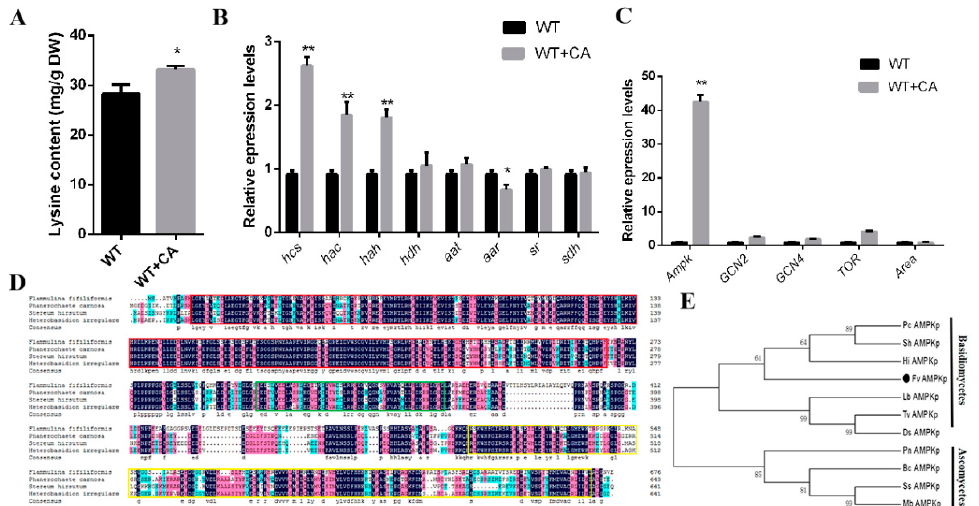
Figure 5. Molecular mechanism of citric acid regulation of lysine biosynthesis in Flammulina filiformis as well as phylogenetic analysis and alignment of the AMPK domains. The asterisks indicate significant differences compared with the untreated strains (Student’s t-test: * p < 0.05 and ** p < 0.01). ( A ) Lysine content of F. filiformis under optimal citric acid induction. ( B ) Changes in transcriptional levels of lysine-synthesis-related enzymes induced by citric acid. Error analysis represents the standard deviation of the three experimental replicates for each treatment. ( C ) Changes in transcriptional levels of key regulators of amino acid metabolism and energy metabolism under optimal conditions of citric acid induction. ( D ) Alignment of AMPK protein sequences of F. filiformis with other basidiomycetes. The dark blue shaded part is 100% conserved; the pink shaded part is 75% conserved; the light blue shaded part is 50% conserved. The red box is conserved protein kinase domain structure; the green box is ubiquitin-associated (UBA) domain structure; the yellow box is AMPK C-terminal α -subunit regulatory structure. ( E ) Phylogenetic tree analysis of AMPK protein of F. filiformis and homologous protein of AMPK in fungi. Sequence alignment and construction of phylogenetic trees of AMPK proteins in fungi were performed using MEGA.6.0. Sequence of other fungal AMPK homologous proteins used to construct phylogenetic trees: Phanerochaete carnosa (Pc AMPKp, XP_007391270.1), Stereum